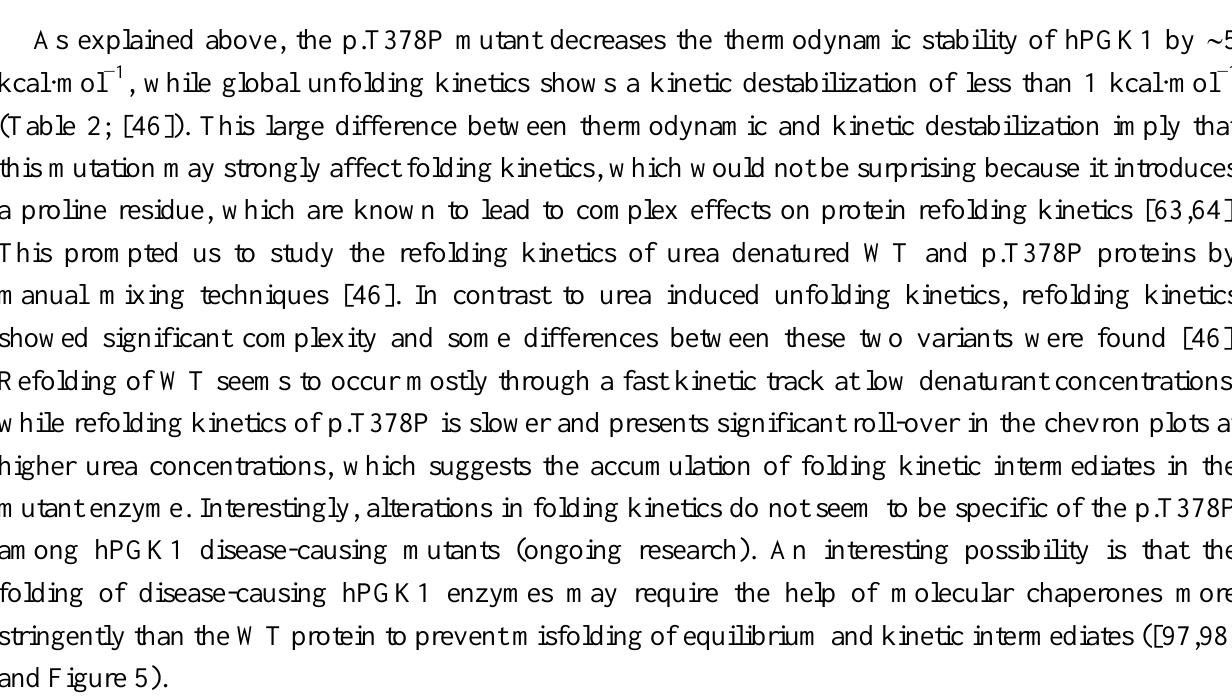
Figure 5. A simple scenario for protein folding and misfolding hPGK1 enzymes inside the cell. Folding of hPGK1 may occur in vivo spontaneously after its synthesis, as seen by its spontaneous folding in vitro [13] and the fast and spontaneous folding of yeast PGK in living cells ([26,99]). Alternatively, the native state can be reached via interaction of partially folded states with different classes of molecular chaperones. The red arrows indicate steps that may be affected in vivo upon disease-causing mutations, mostly associated with reduced native stability and folding cooperativity [13,46]. The potential targets for pharmacological correction by proteostasis modulators (PM) and pharmacological chaperones (PC) are also